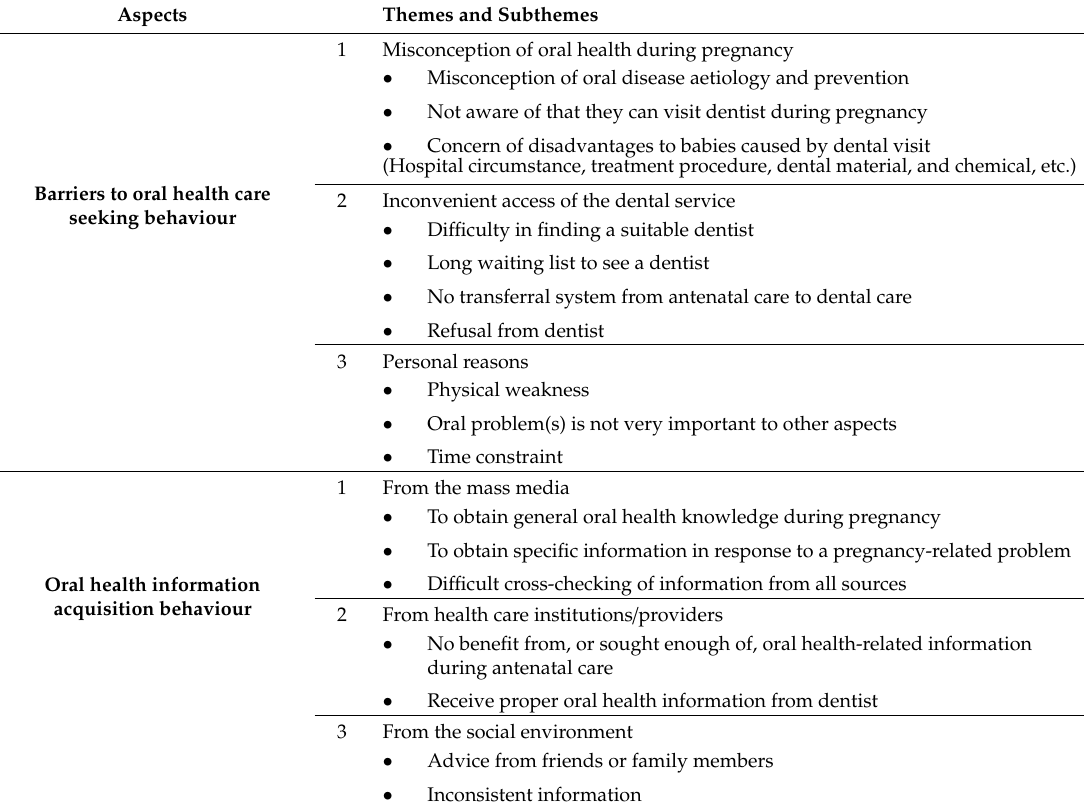
Table 2. Themes and subthemes